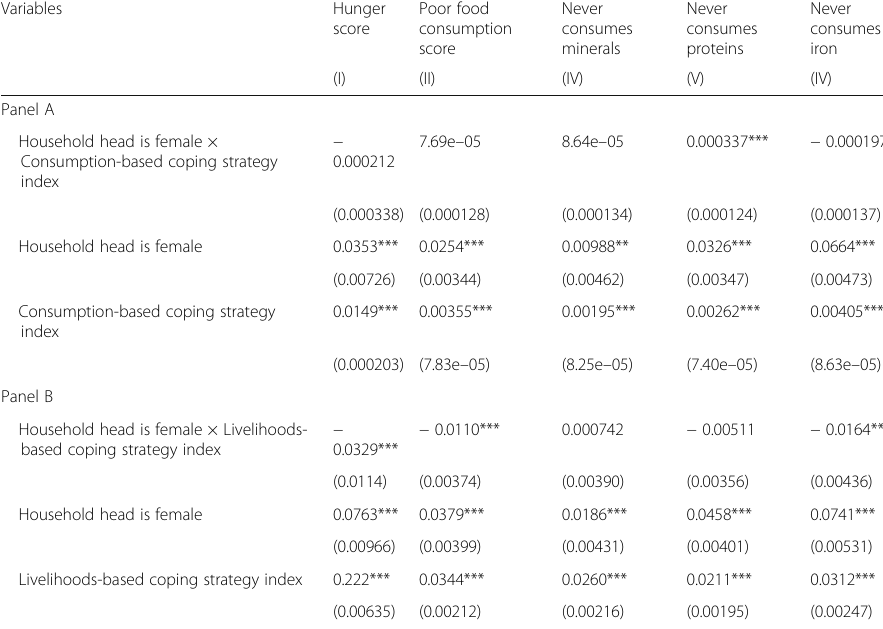
Table 7 OLS estimates of gender heterogeneity in the usage of coping strategies when confronted with food and nutrition insecurity